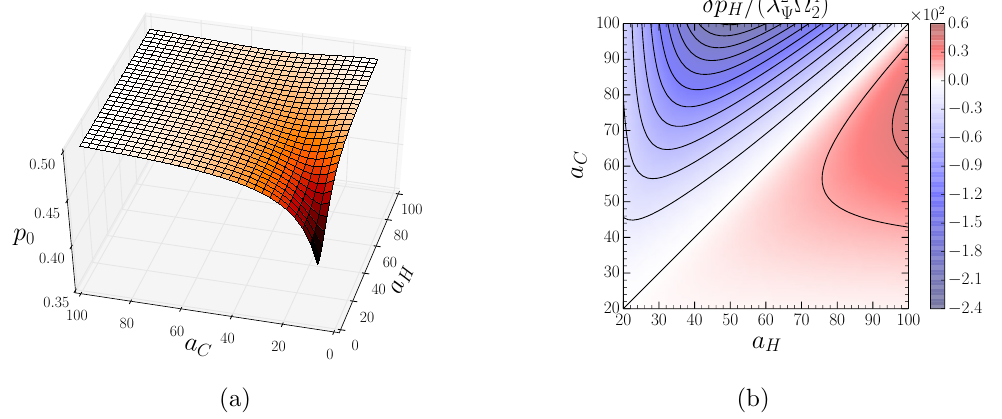
Figure 8. For the fermionic interaction with v = 0 : 8 and (cid:10) 2 = (cid:10) 1 = 2; (a) shows the critical probability for completing the thermodynamic cycle and (b) the correction (cid:14) (cid:22) p H as a function of the critical probability. Red regions show where we get positive work and blue